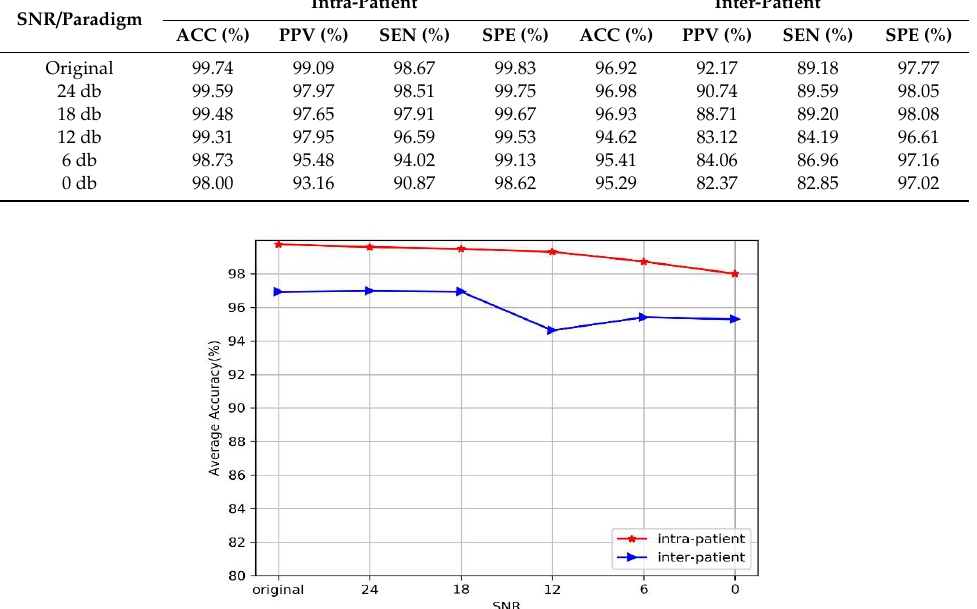
Table 11. The average performance of di ff erent SNRs under intra-patient and inter-patient paradigms. SNR / Paradigm